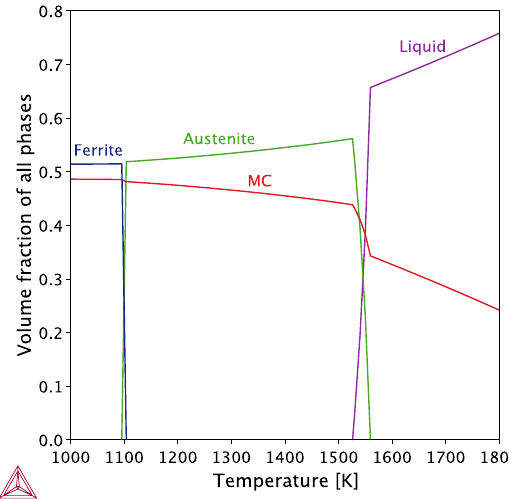
Figure 3. Fe-V-C Property diagram.